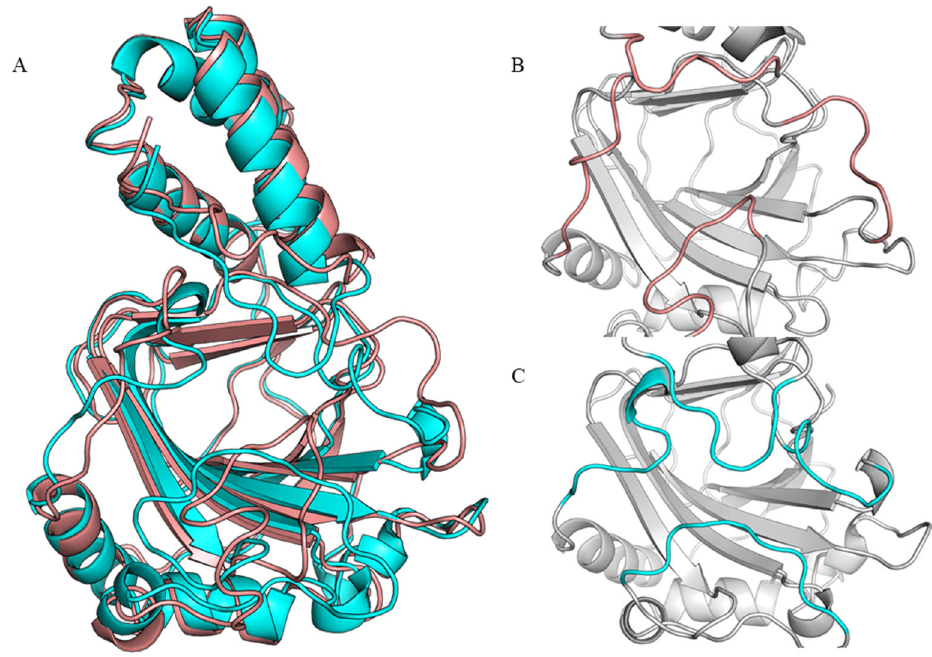
Figure 3. Structural analysis of cis -P3H: ( A ) structural alignment for cis -P3H: homology modeling result based on cis -P3H (type II) (salmon) and AlphaFoldDB (P96010, cyan); ( B ) loop region obtained from homology modeling; and ( C ) loop region of P96010.